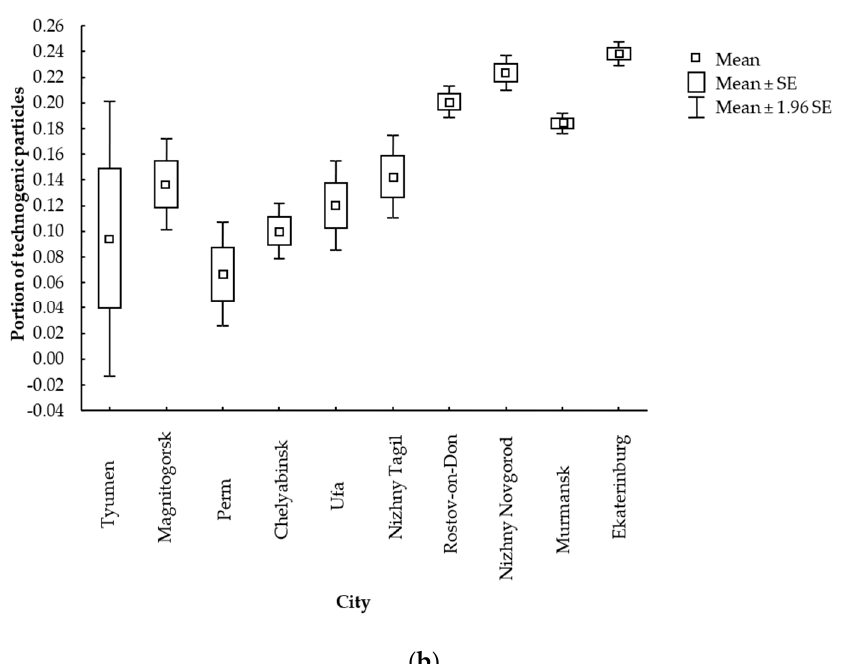
Figure 3. The proportion of technogenic particles in the cities: ( a ) in the particle size fraction of 0.1–0.25 mm, ( b ) in the particle size fraction of 0.25–1 mm (SE—standard error).